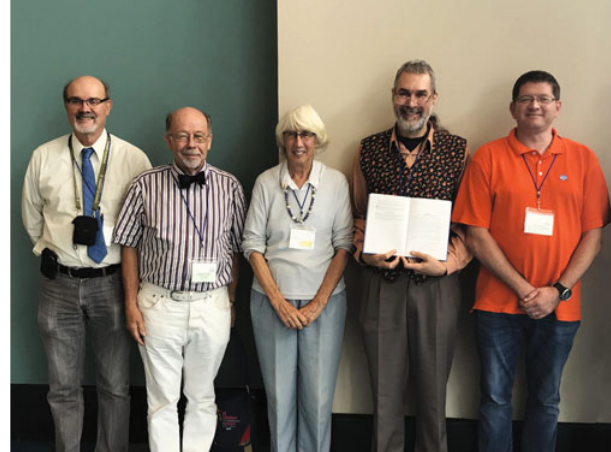
Fig. 2. Members of the Fungal Nomenclature Bureau, IMC11 ( left to right ): Scott Redhead (Deputy Secretary), David Hawksworth (Deputy Chair Emeritus), Amy Rossman (Chair), Tom May (Secretary, holding Chapter F of the Shenzhen ICN ), and Lorenzo Lombard (Recorder). Photo: Wilhelm de